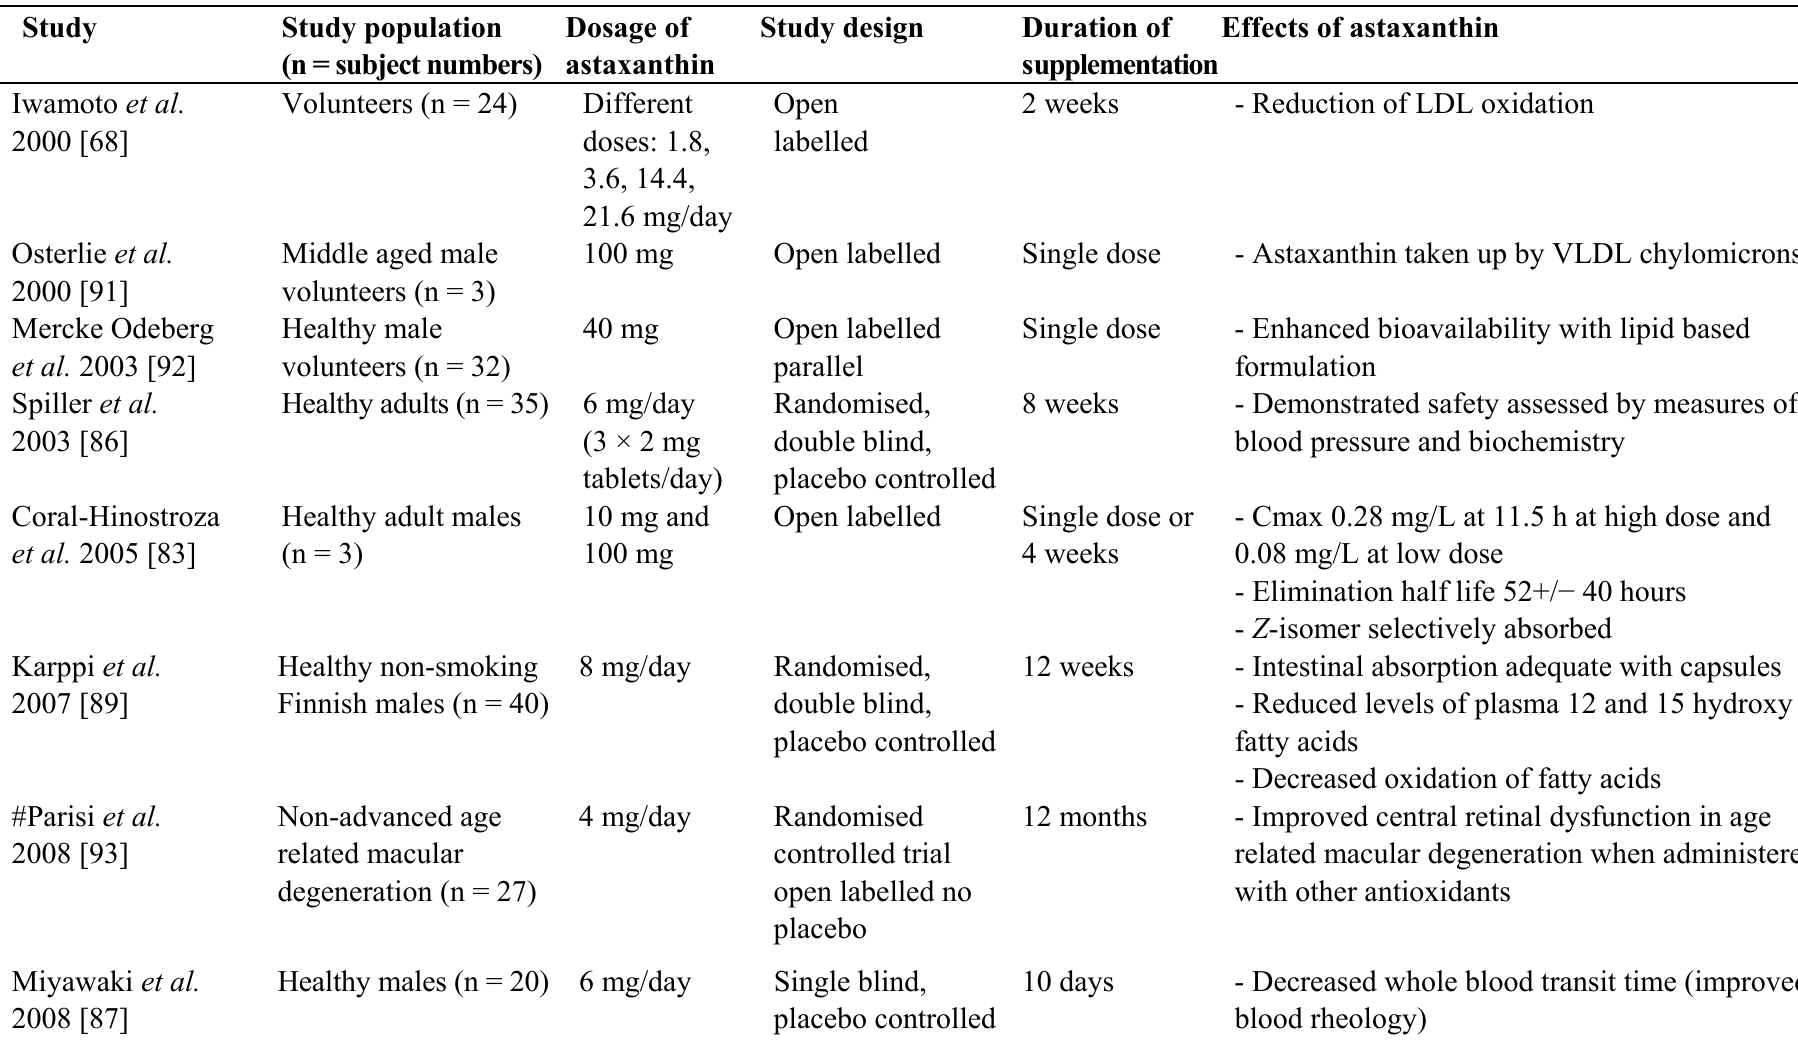
Table 2. Clinical studies investigating the safety, bioavailability and effects of astaxanthin on oxidative